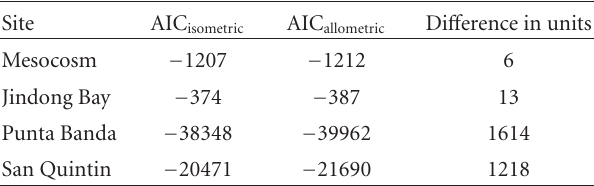
Table 4: Comparison of the Akaike Information Criterion (AIC) indexes between the isometric and the allometric model for all